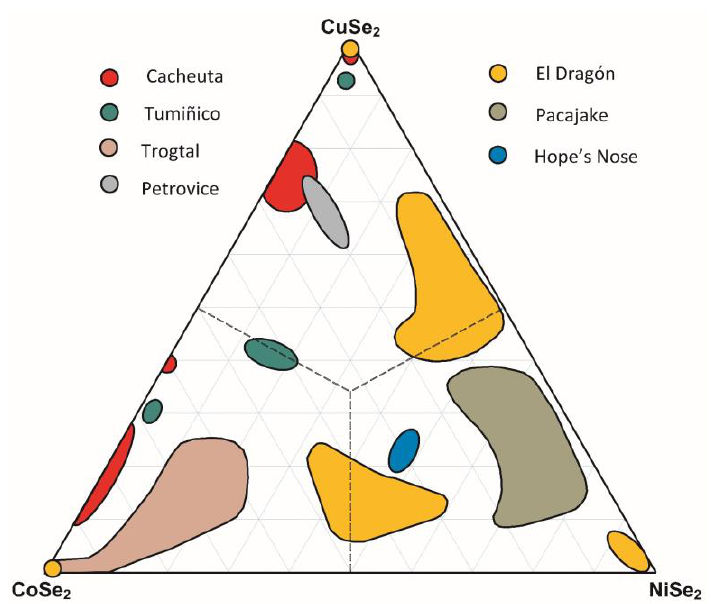
Figure 17. Co–Ni–Cu ternary diagram (mole %) of the system trogtalite–penroseite–krut’aite. Data